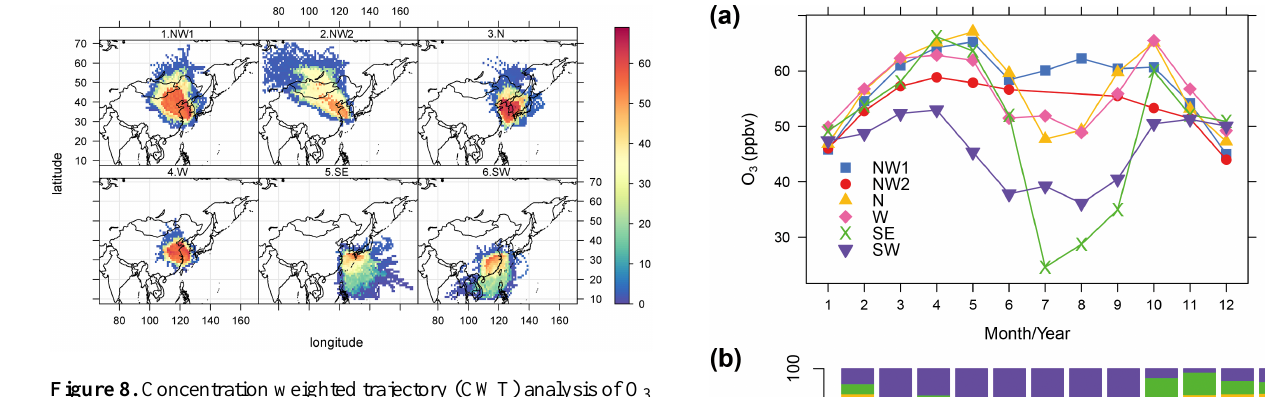
Figure 8. Concentration weighted trajectory (CWT) analysis of O 3 concentrations (ppbv).